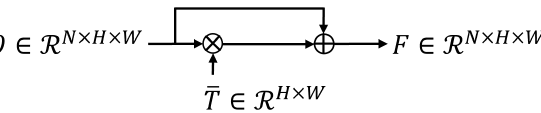
Figure 3. Medium transmission guidance module. The MT map T is a feature selector. T weighs the importance of the different spatial positions for F . ⊗ pixel-wise multiplication. ⊕ pixel-wise